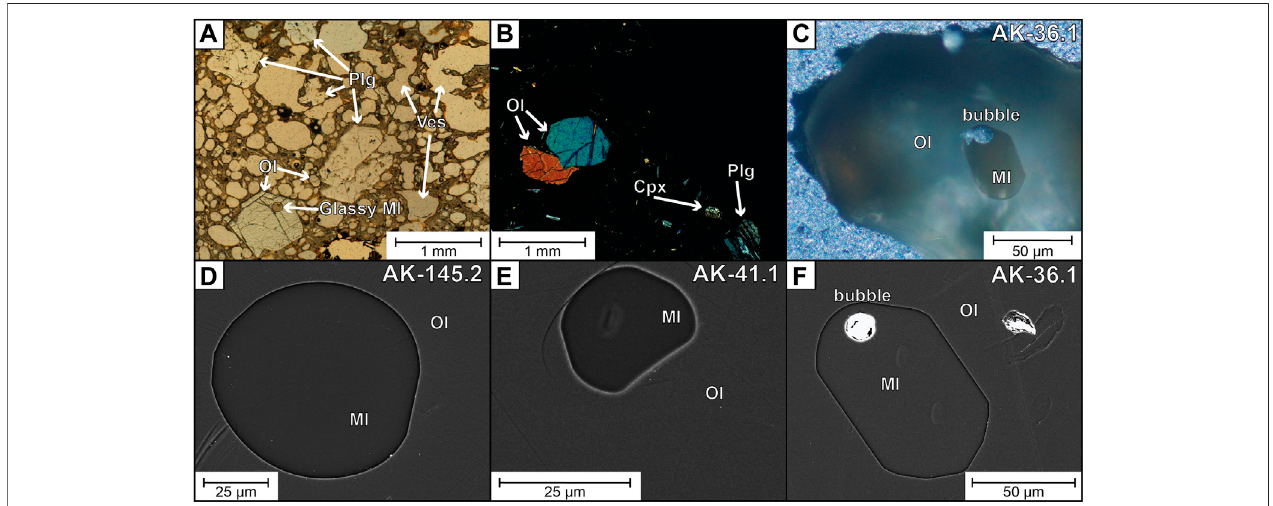
FIGURE 5 | Photographs of the AK sample. (A) Thin section parallel polarized light microphotograph. (B) Thin section cross-polarized light microphotograph. (C) Oblique light microphotograph of olivine-hosted MI. (D) to (G) BSE images of olivine-hosted MIs. (C) and (G) correspond to the MI used as initial composition during modelling, and (D) and (F) are MIs with evidence for low and high PEC, respectively (see text). Plg (cid:2) plagioclase, Ol (cid:2) olivine, Cpx (cid:2) clinopyroxene, MI (cid:2) melt inclusion, Ves (cid:2) vesicle.